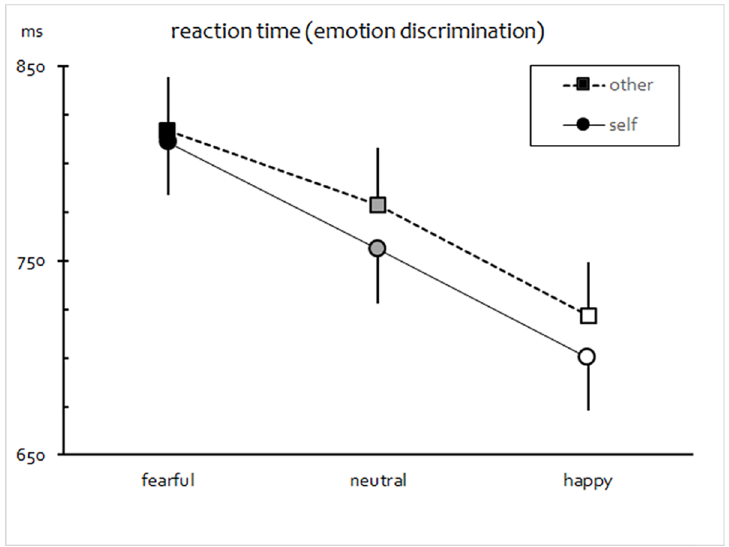
Fig 3. Mean RT as a function of emotional expression and facial resemblance (self vs. other). Error bars represent SEM.